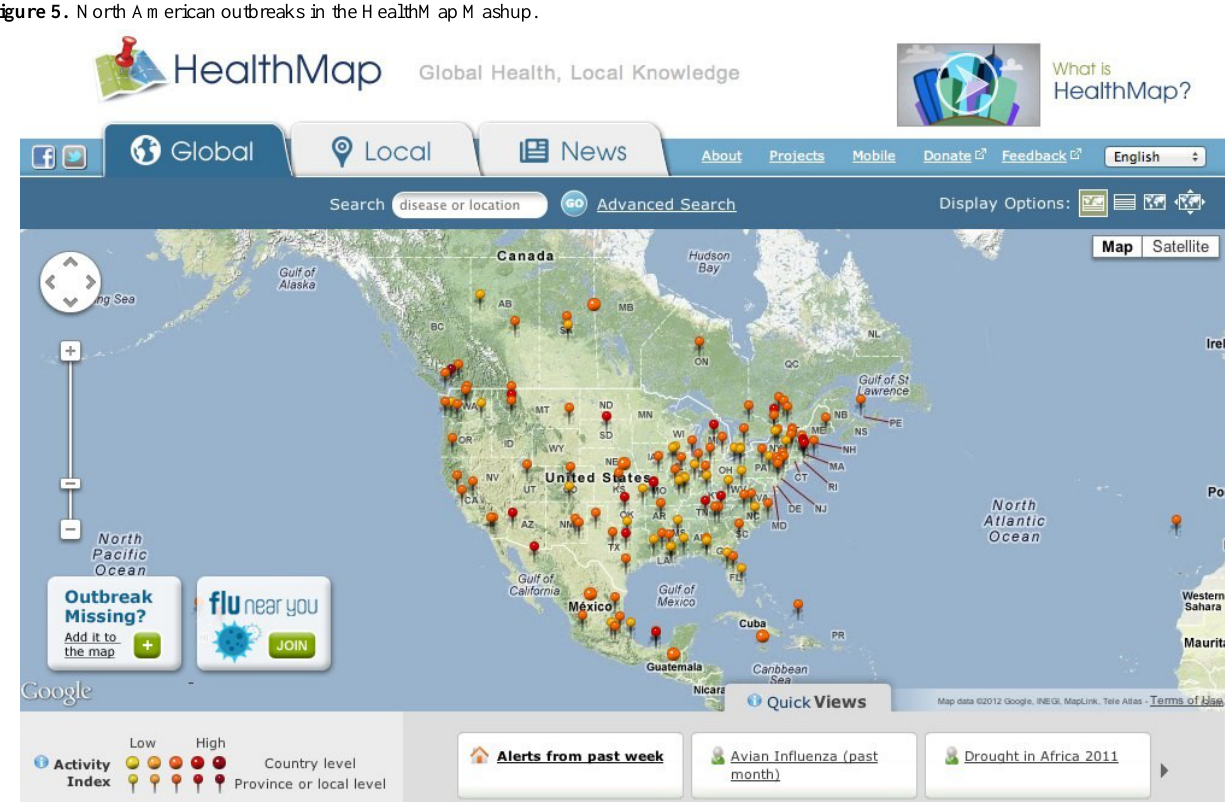
Figure 5. North American outbreaks in the HealthMap